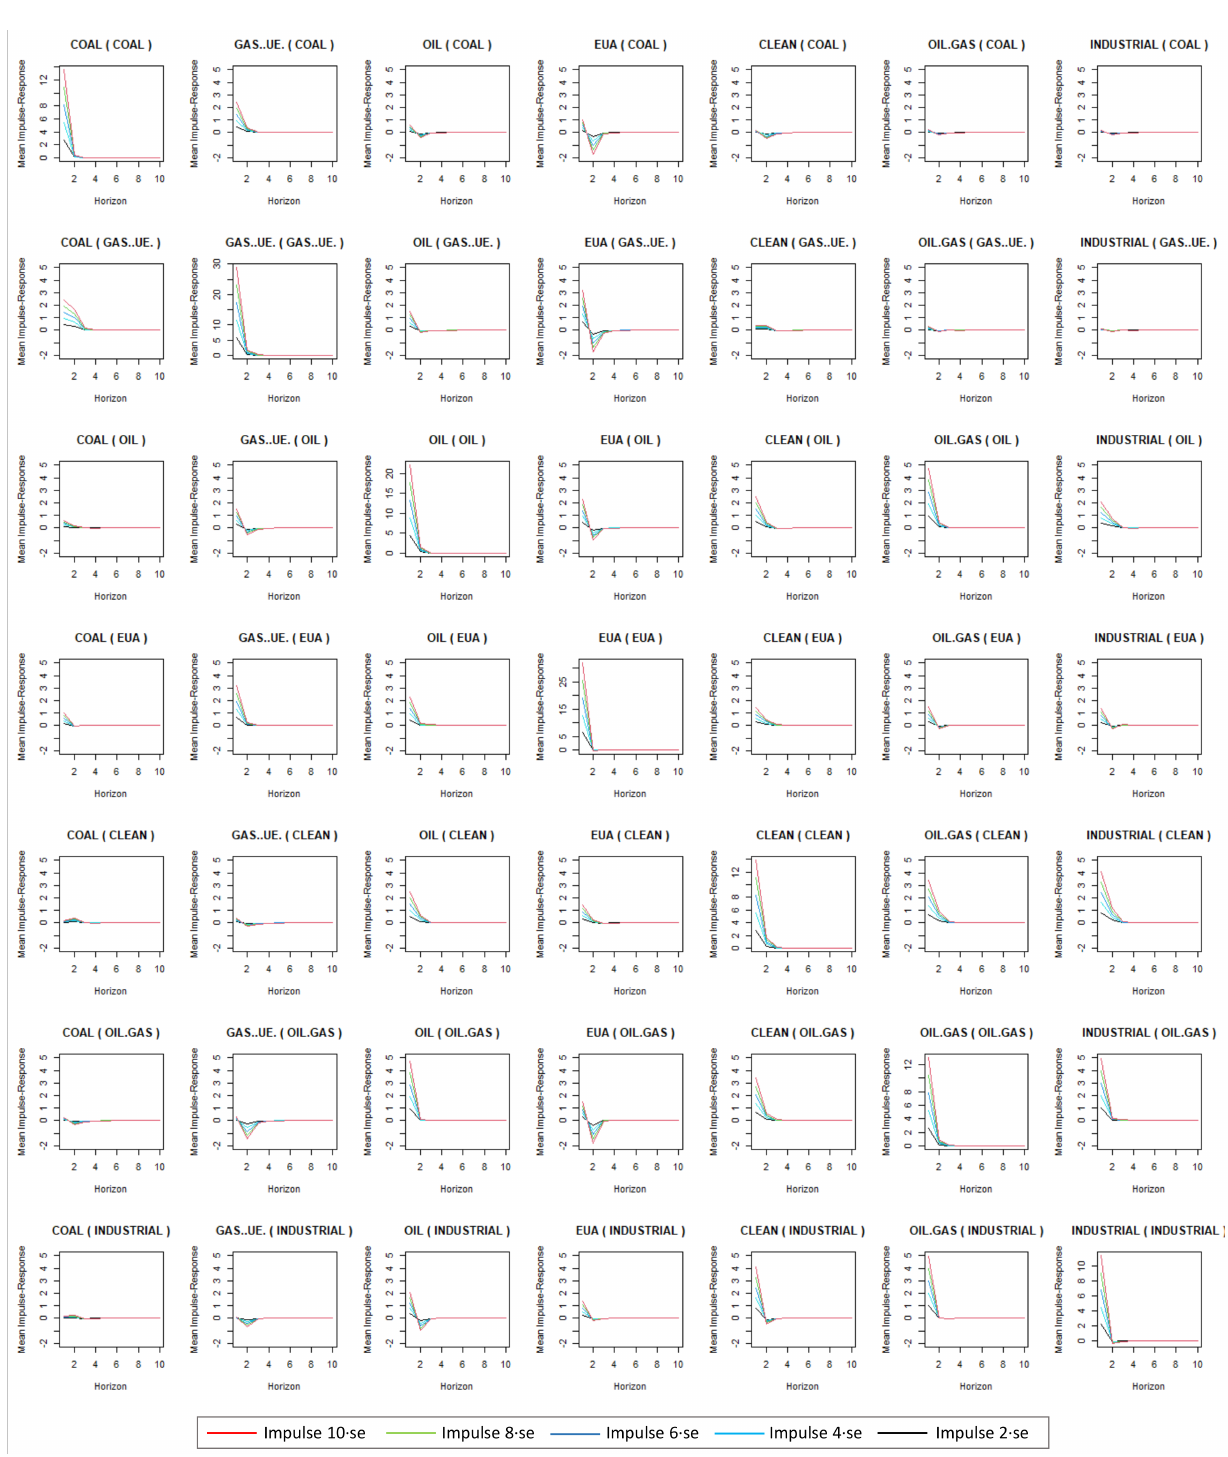
Figure 6. Matrix graph with the mean impulse response curves for several forecast horizons and shock sizes. The off- diagonal cells contain the response of the conditional mean of one variable, when the shocked variable is a different one and the diagonal cells encloses the responses when the shocks are produced on itself (the shocked variable in